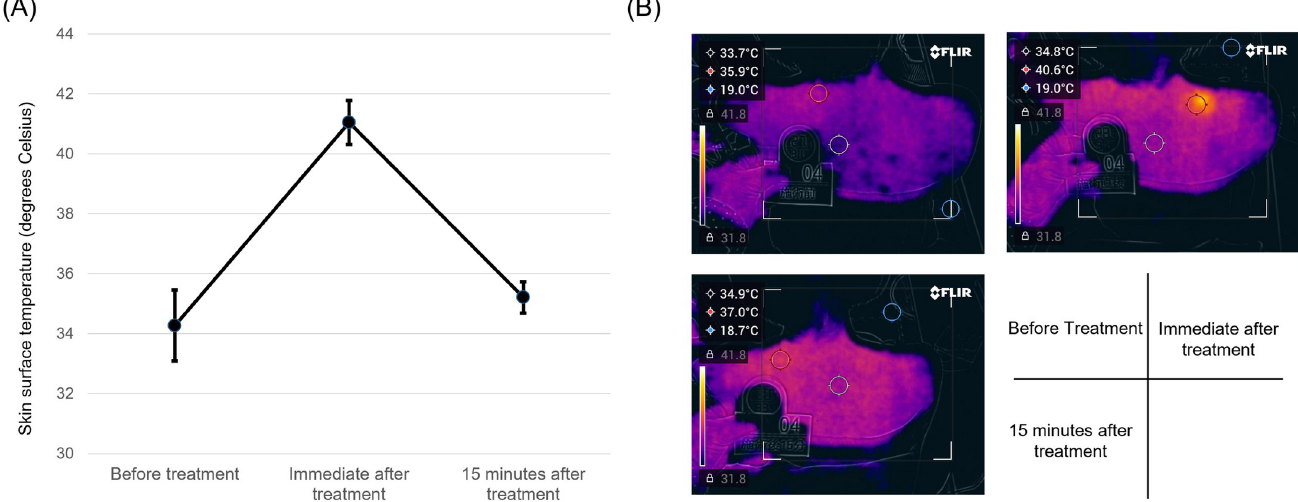
Fig 3. The effect of LED light irradiation on the skin surface temperature. (A) Variations in the skin surface temperature around the LED light irradiation site of each study participant before, immediately after, and 15 minutes after treatment. (B) Thermography images of the skin surface before (upper left), immediately after (upper right), and 15 minutes after LED irradiation (lower